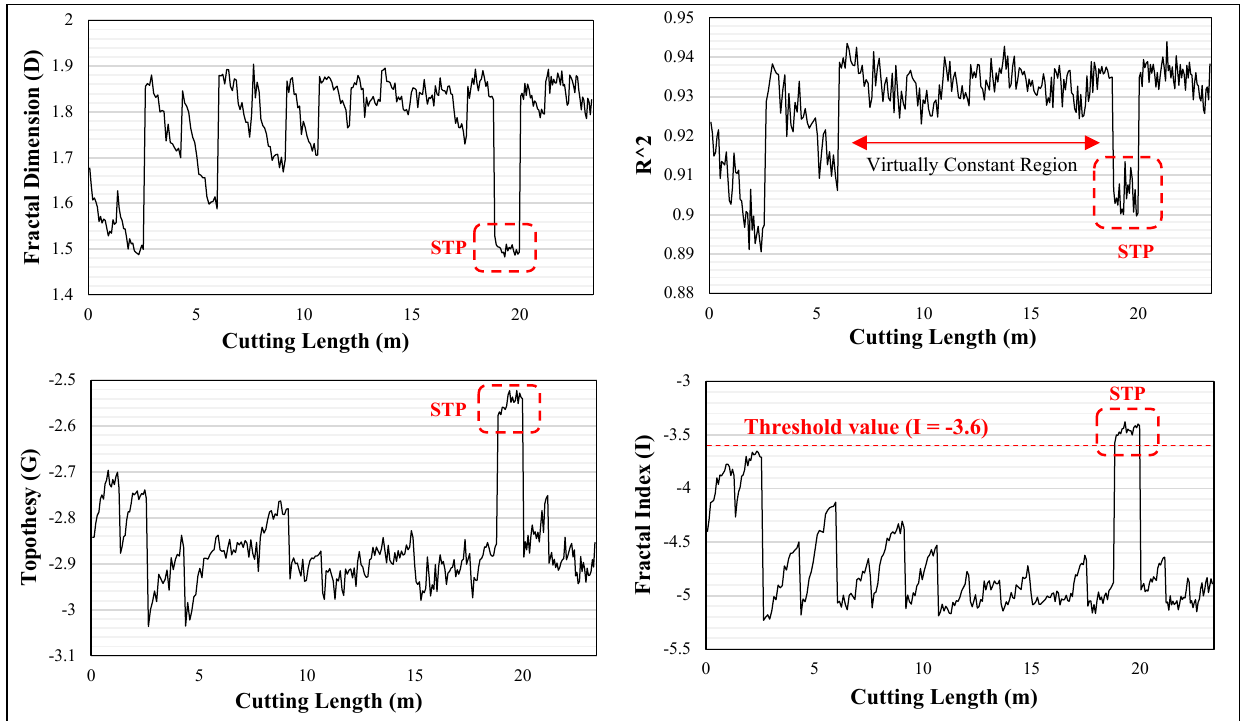
Figure 9. The fractal parameters of the spindle electric current signal during shoulder milling of the AISI 5140 steel block.